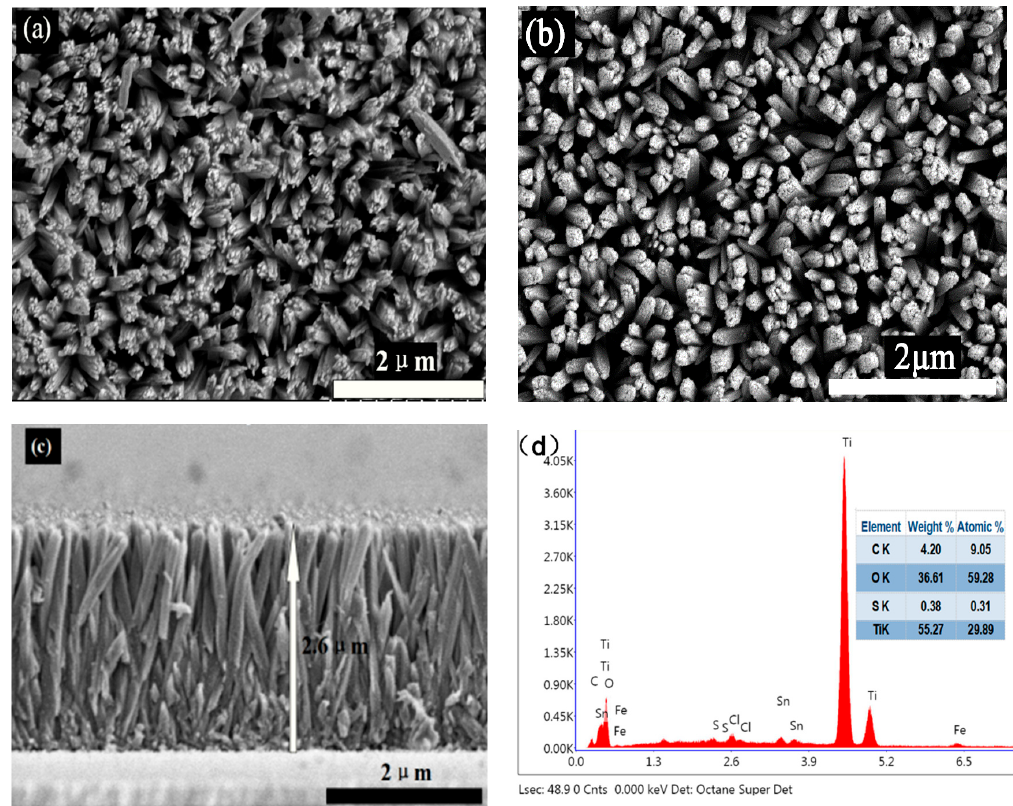
Figure 3. Field emission scanning electron microscopy images of the samples: ( a ) top view of the 0.24S 2 − -TiO2 sample, ( b ) top view of bare TNA sample and ( c ) cross-section view of the 0.24S 2 − -TiO2 sample. ( d ) Energy dispersive X-ray (EDX) analysis of the 0.024S 2 − -TiO 2 sample.